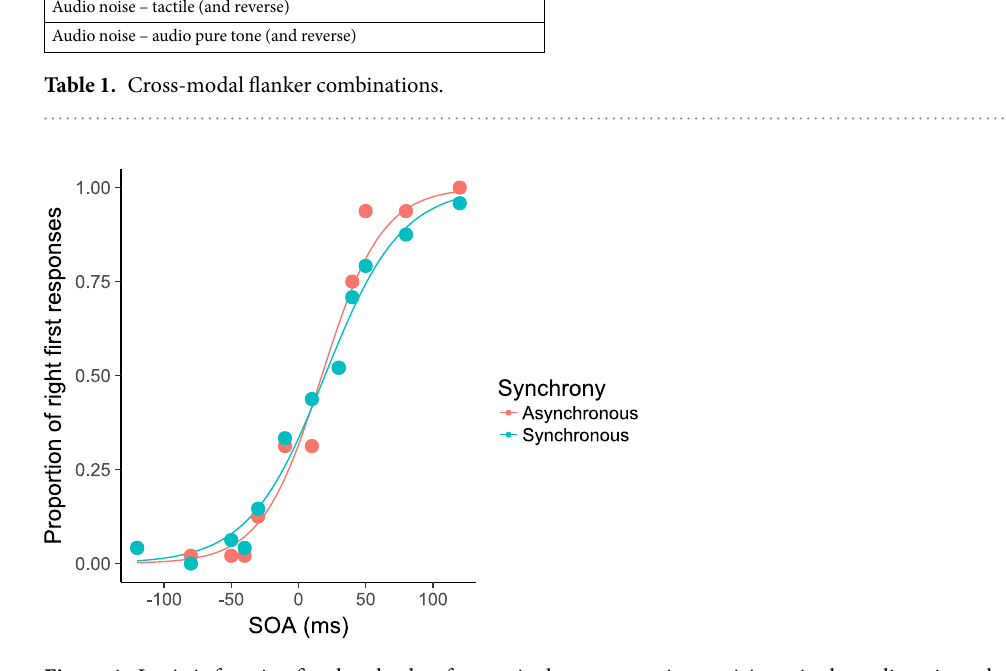
Figure 4. Logistic function fitted to the data from a single representative participant in the audio noise only condition (cross-modal flankers were the same), presented synchronously and asynchronously with the visual onsets. Y-axis represents the proportion of ‘right first’ responses. The steeper slope for reports in the ‘Asynchronous’ presentation condition is consistent with temporal